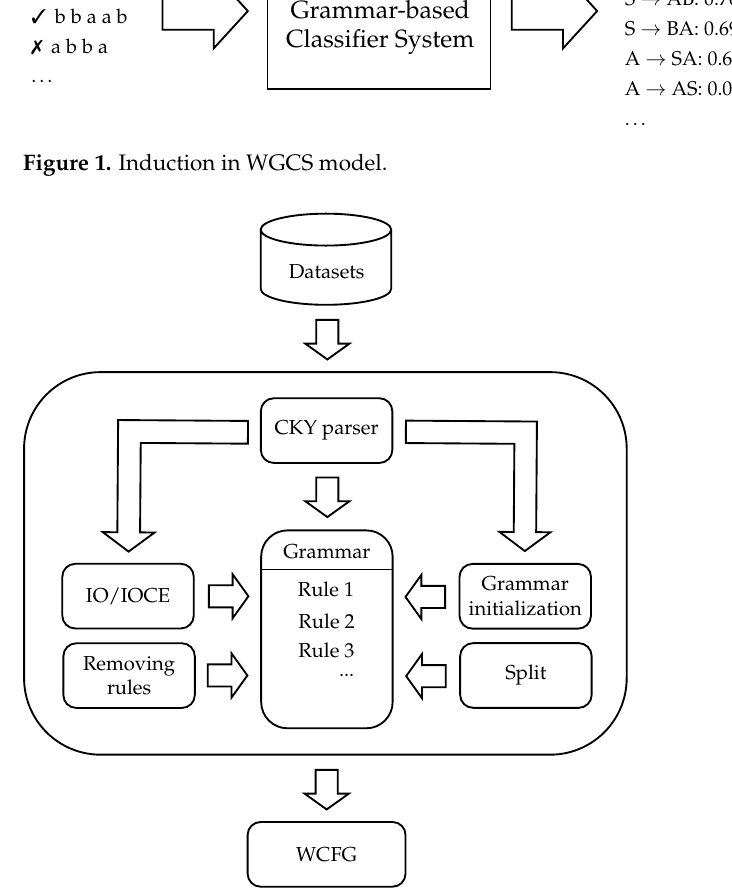
Figure 2. General architecture of the WGCS